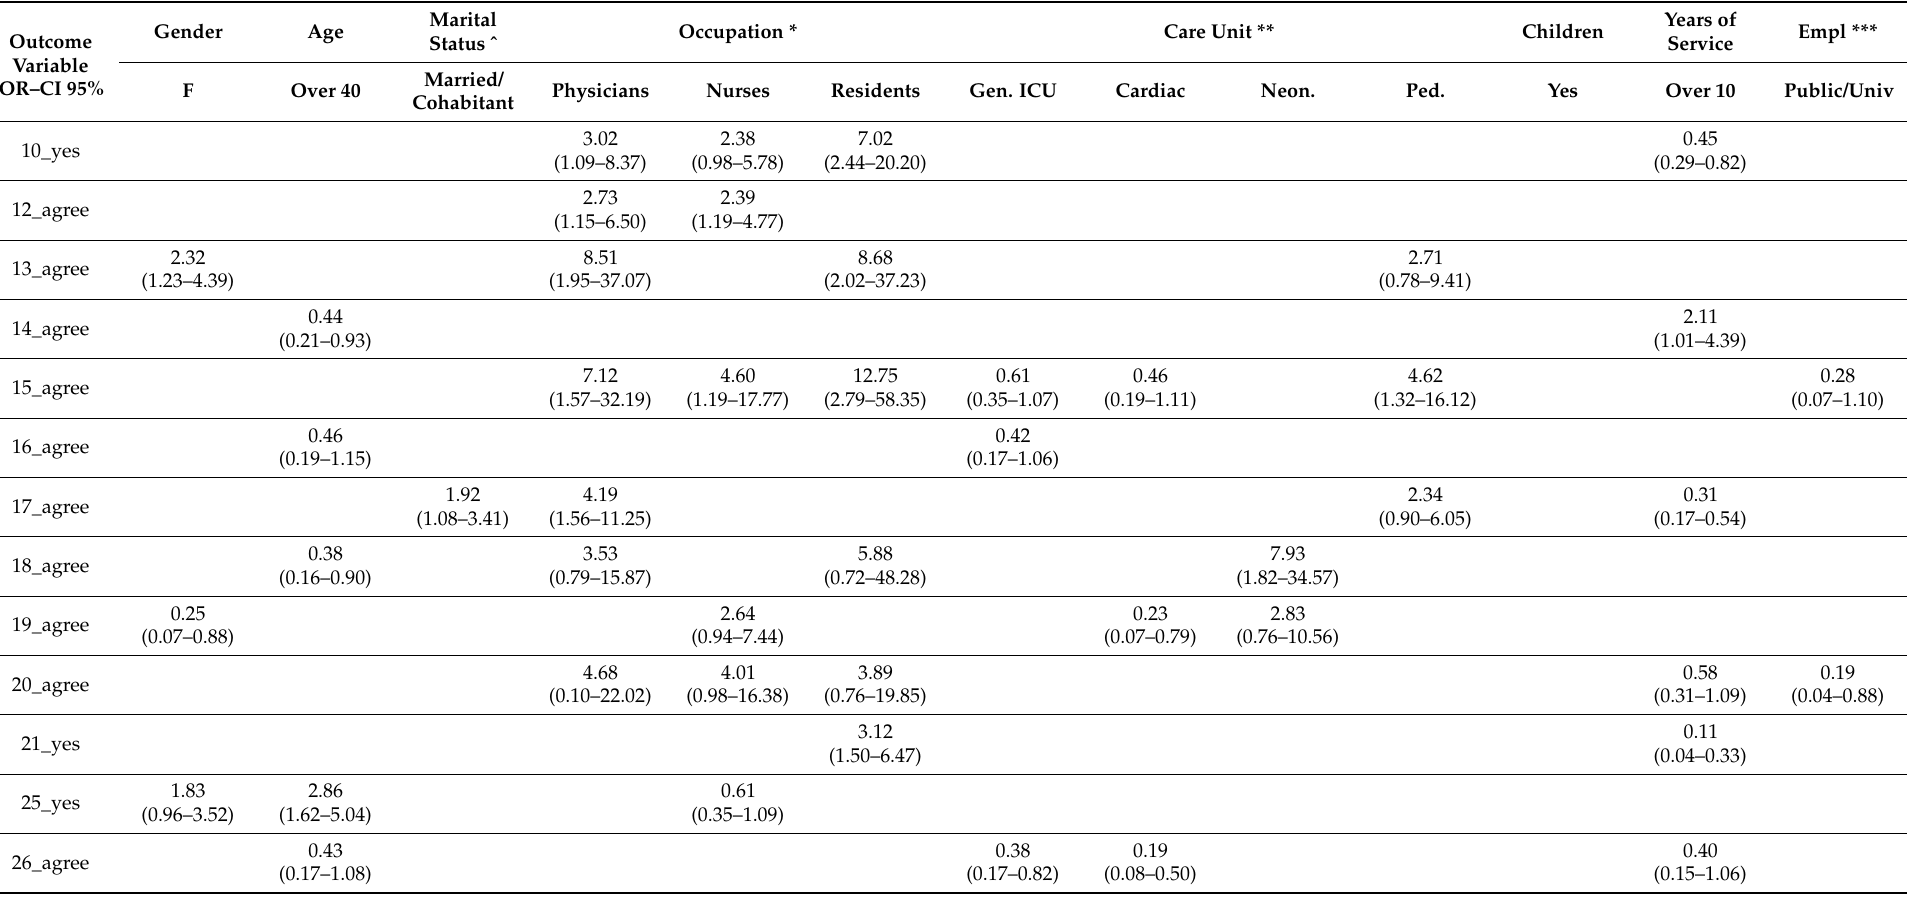
Table 6. Results of multivariate analysis—OR (95%CI) positive